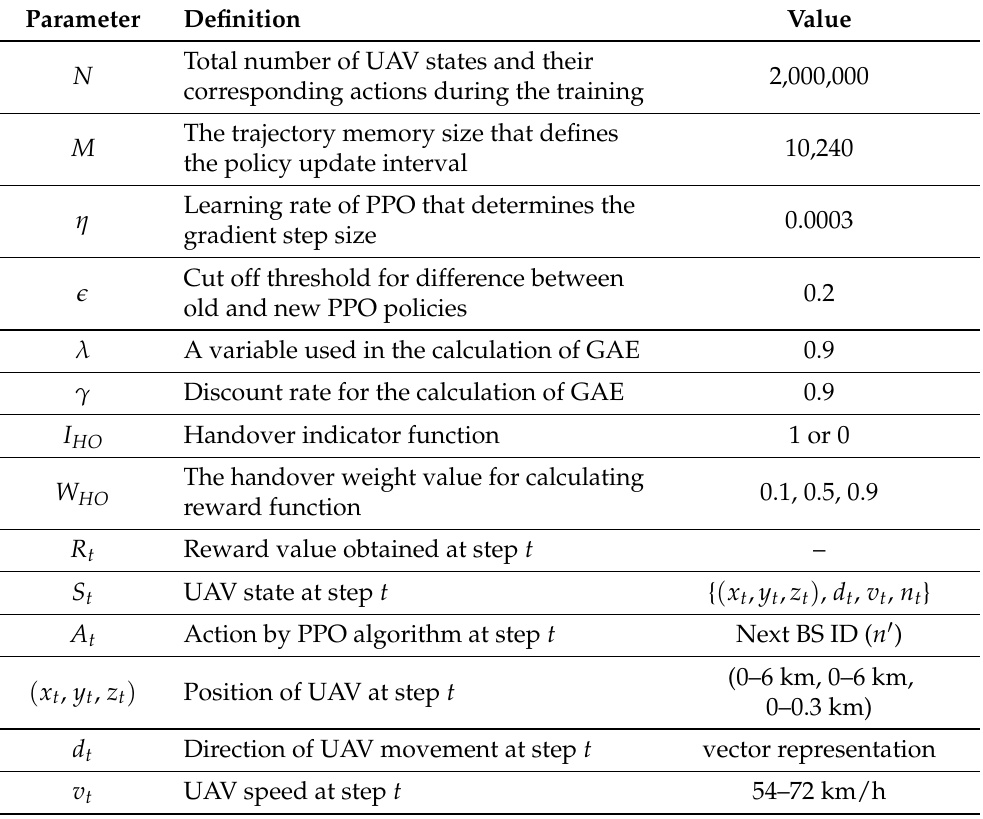
Table 1. Parameter definitions and